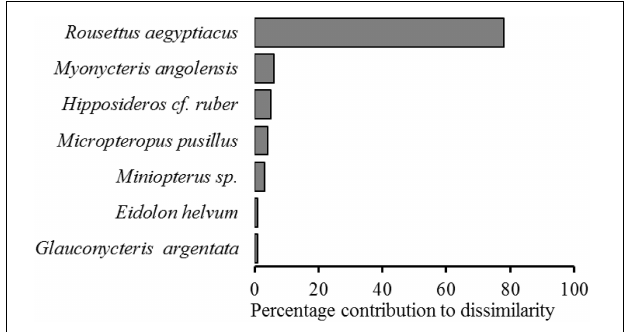
FIGURE 6 | Species that contributes the most ( > 1%) to the community dissimilarity of bat species between undisturbed and disturbed habitat sites of the Afromontane biome of western Cameroon.